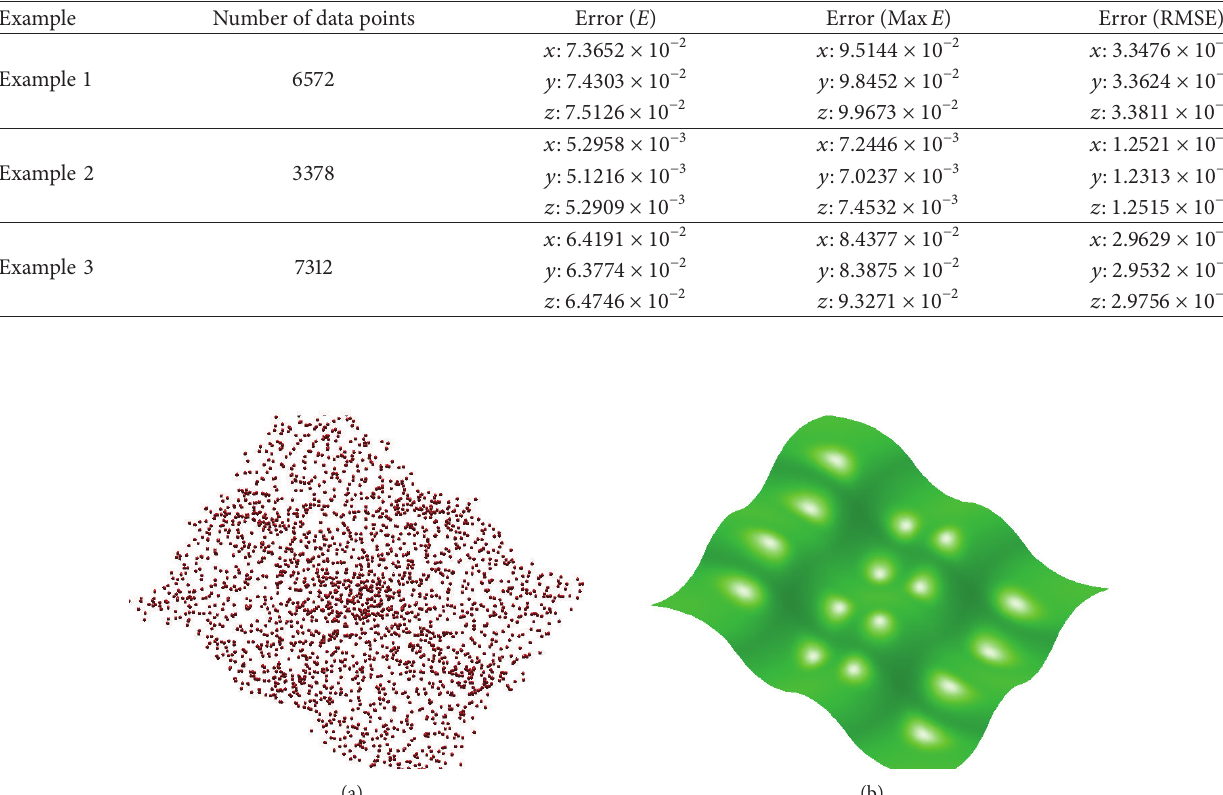
Figure 1: Applying the firefly algorithm to B´ezier surface approximation of data points: (a) original data points; (b) best approximating B´ezier surface.